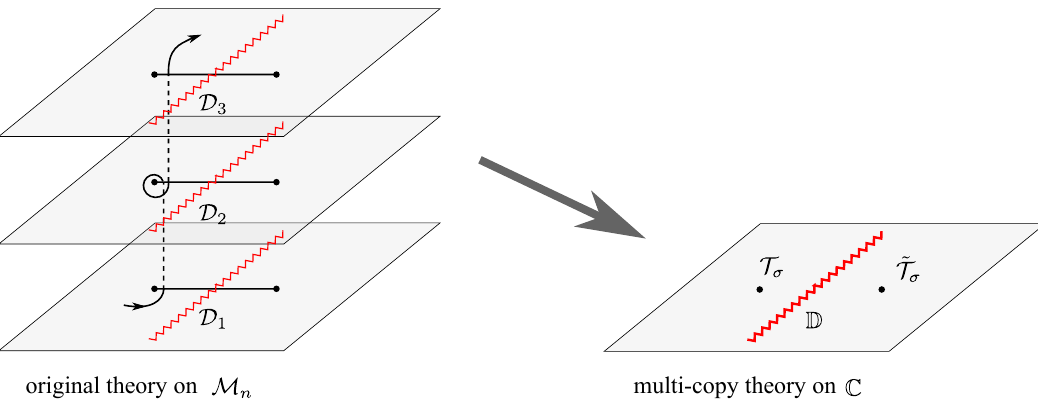
Figure 2 . Multiple copies of the original theory glued together. Here we take n = 3. The dashed lines are the integrable line defects and the black lines are branch cuts.